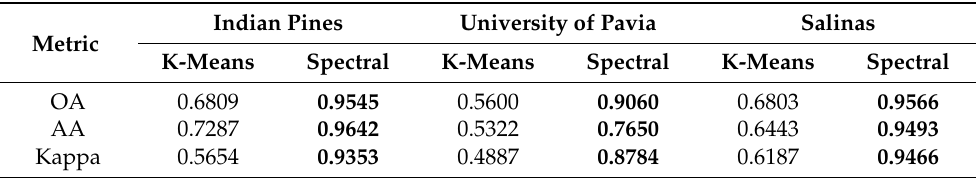
Table 9. Accuracy with K-means clustering and spectral clustering. The best results obtained for each dataset are bolded.